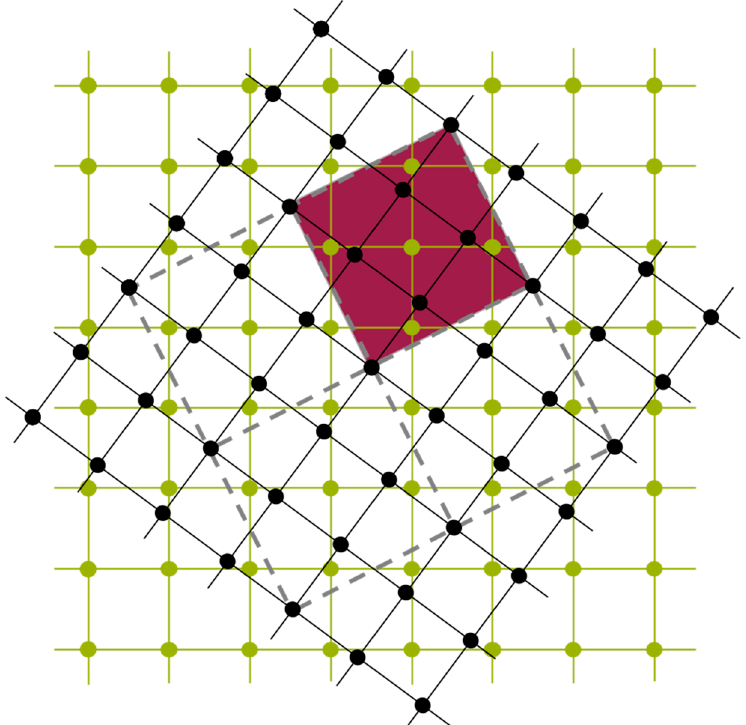
Figure 7. Model of a Σ 5(001) twist grain boundary. The adjacent crystal lattices are indicated in green and black. Note that prior to the rotation (twist) the black lattice points have been found above the centres of the squares formed by the green lattice points. For the rotation shown in the figure some of the black lattice points again coincide with the centres of the squares of the green lattice and the square spanned by these points as indicated in purple comprises five points of the green lattice. Within the coincident site lattice theory [30] a maximum number of coincidences of the original and rotated lattice points lets expect a minimal grain-boundary energy.